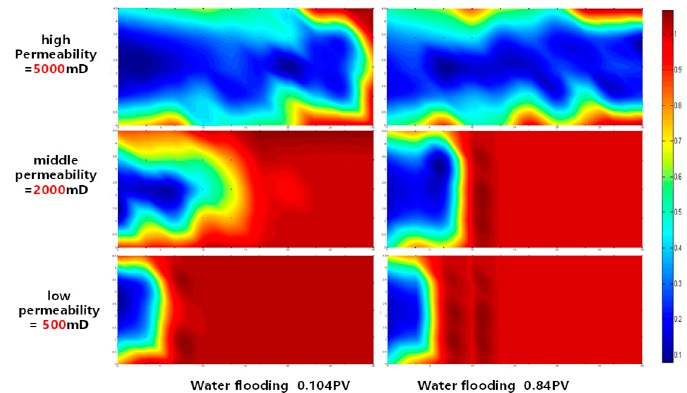
Figure 10. Residual oil distribution of waterflooding when injecting 0.101 PV (left, water breakthrough) and 0.84 PV (right) of water.